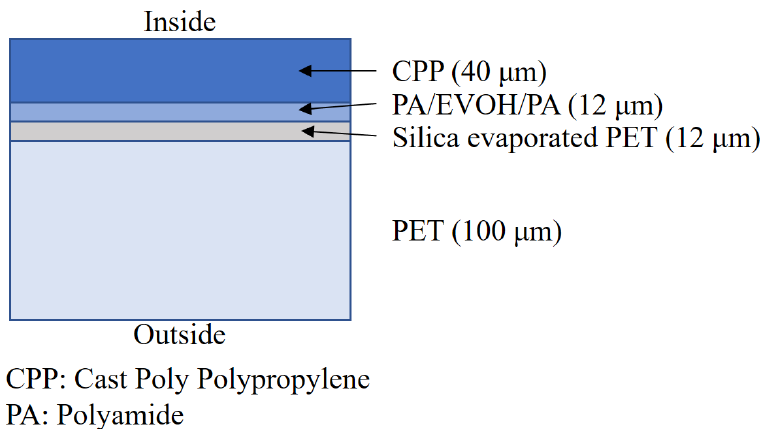
Figure 8. Manufacturing flow of the VIP specimens.